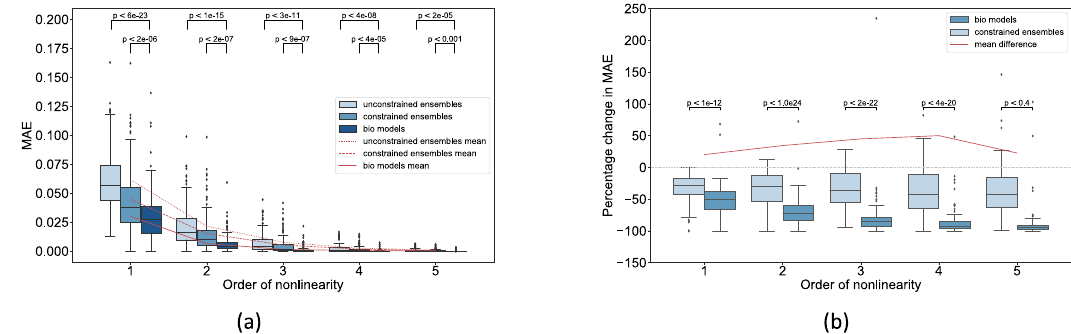
Fig. 2 Biological models are more approximable than expected by chance. a The MAE of the biological models and the associated constrained and unconstrained ensembles for approximation orders 1 to 5; MAE values for orders 6 and above are negligible and not shown. b Percentage change in MAE for the biological models and the associated constrained ensembles computed with respect to the MAE of the corresponding unconstrained ensembles. Every point in the distributions corresponding to the random ensembles represents the average MAE of an ensemble of 100 random networks associated with each biological model. The p values indicate the statistical signi fi cance of the difference in mean MAEs between sets of random ensembles and the biological models for a given order of nonlinearity. Statistical analysis by Welch ’ s unequal variances t